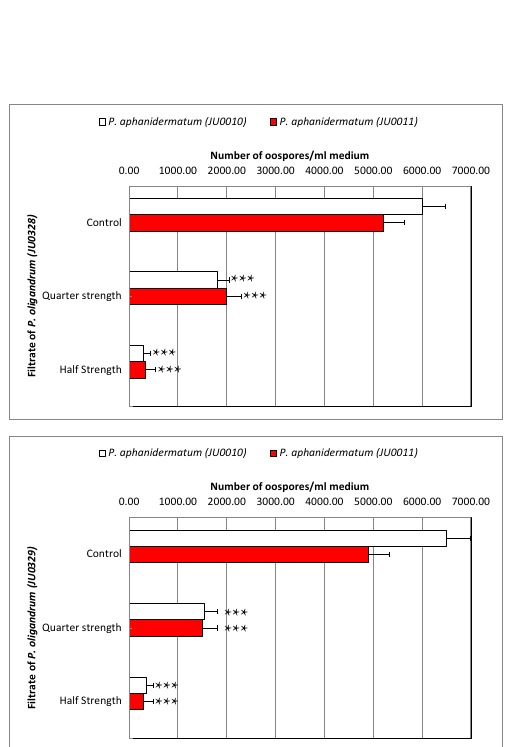
Fig. 3. Effect of cultural filtrate of two isolates of P. oligandrum on oospore production by two isolates of P. aphanidermatum after 24 h at 20°C in the dark. Bars above all drawing column, represent the standard error of the average data from three replicates and reflect differences between averages of the samples compared to the control sample. Significant values against control represent: ** = highly significant at p < 0.01, *** = very significant at p <